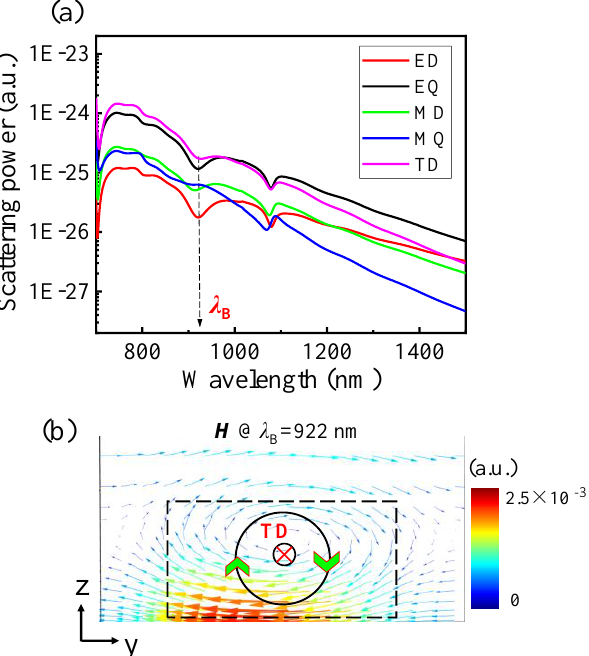
Figure 5. ( a ) Scattering spectra for ED, MD, EQ, MQ, and TD modes under backward illumination. ( b ) Cross-sectional vectorial (y–z plane) for the magnetic-field ( H -field) maps for the excitation of toroidal dipole (TD). The black dashed line marks the outline of Al 2 O 3 disk, while the black circular lines along the circumference indicate toroidal moment. The green arrow marks the circular magnetic field direction, and the direction of TD is shown by the symbol .